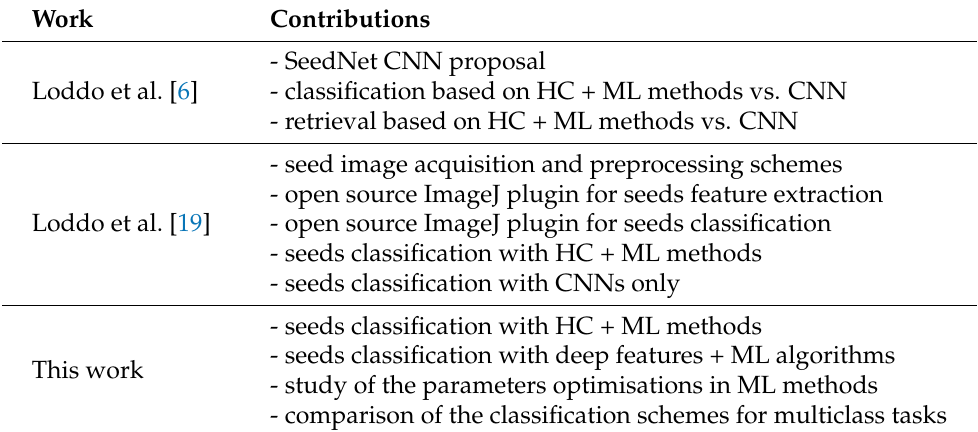
Table 1. Contributions of current and our previous work in the context of seeds images